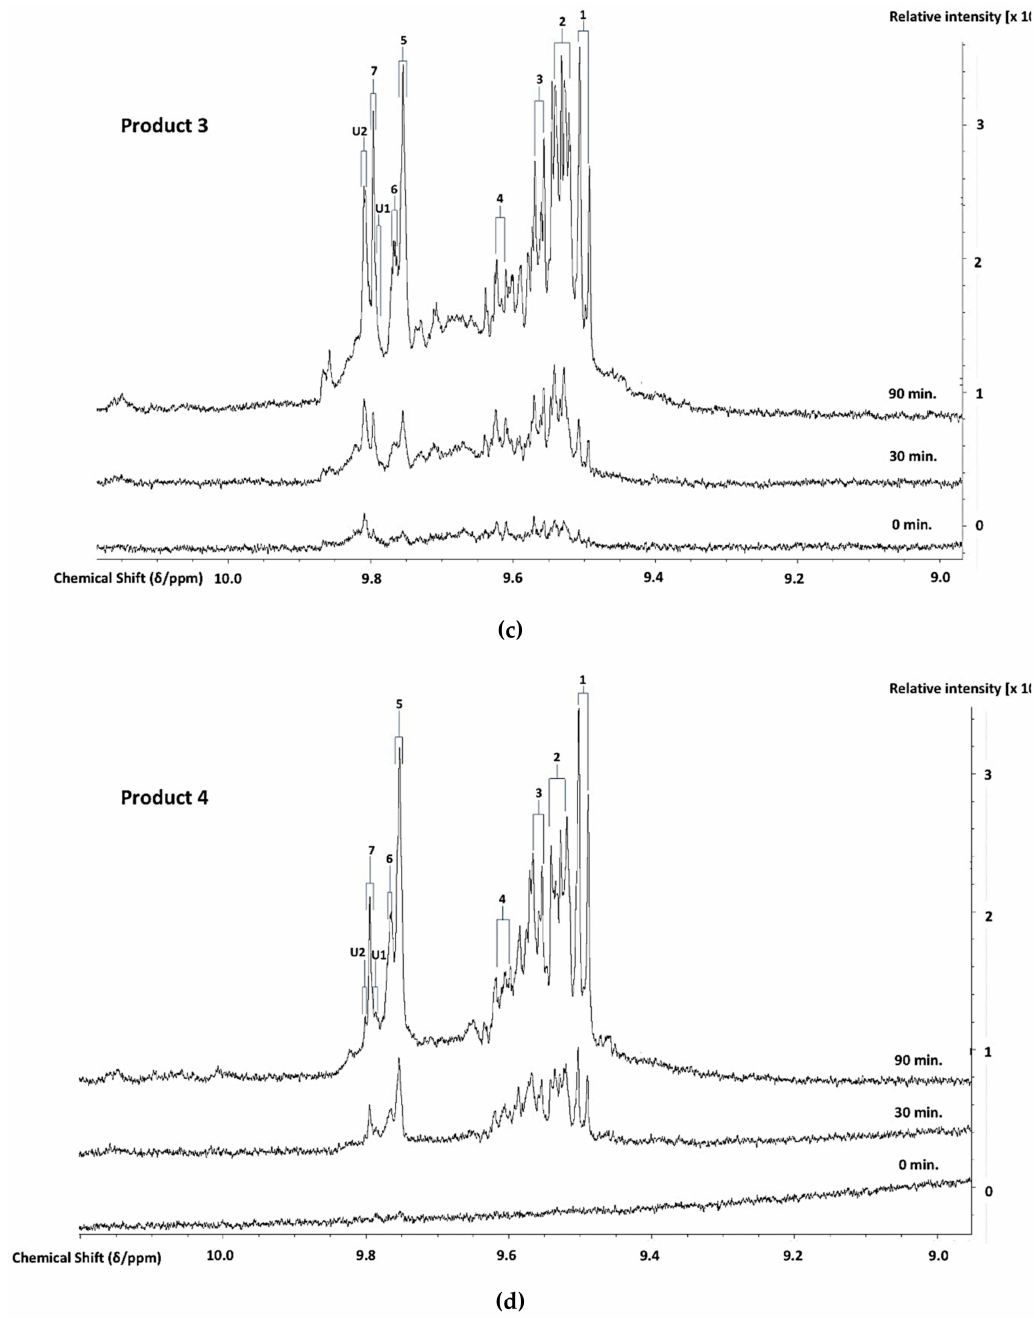
Figure 2. 600 MHz 1 H NMR Profiles of Aldehydes Generated During TORA TSEs. Expanded aldehydic-CHO proton (8.95-10.25 ppm) regions of the 600 MHz 1 H NMR spectra of ( a ) Product 1, ( b ) Product 2, ( c ) Product 3, and ( d ) Product 4 CLOs exposed to TSEs at 180 ◦ C for periods of 0, 30, and 90 min. Typical spectra are shown (the right-hand side ordinate axes indicate the relative intensities of profile resonances). Abbreviations: Number labels correspond to the -CHO function resonances of 1, trans -2-alkenals; 2, trans , trans -alka-2,4-dienals; 3, combined 4,5-epoxy- trans -2-alkenals / acrolein;